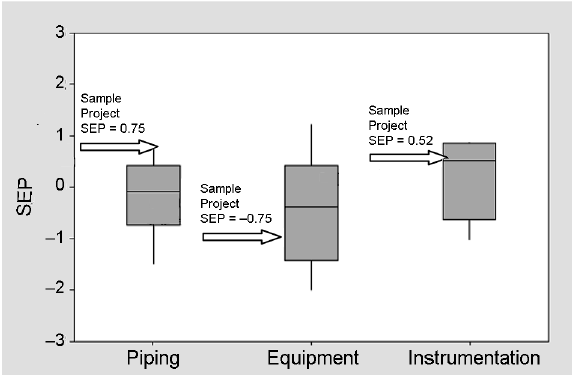
Fig. 8. Benchmarking at the discipline